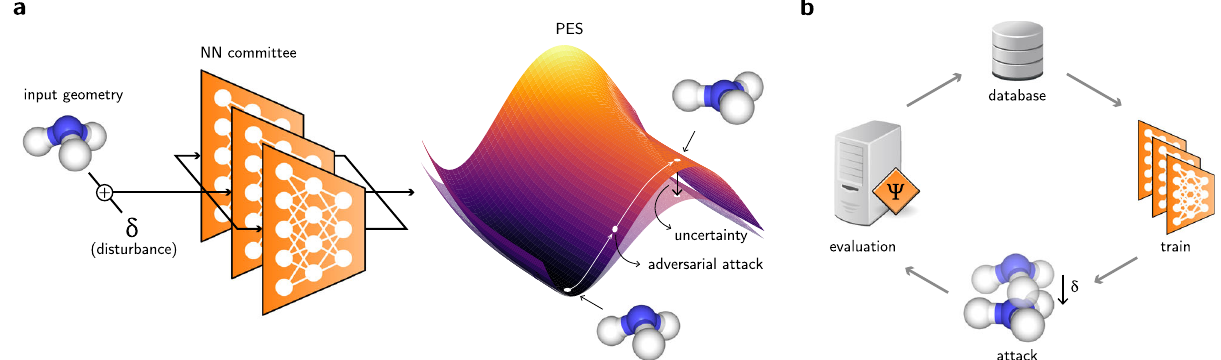
Fig. 1 Schematic diagram of the method. a Nuclear coordinates of an input molecule are slightly displaced by δ . Then, a potential energy surface (PES) and its associated uncertainty are calculated with an NN potential committee. By backpropagating an adversarial loss through the NN committee, the displacement δ can be updated using gradient ascent techniques until the adversarial loss is maximized, thus converging to states that compromise high uncertainty with low energy. b Schematic diagram of the active learning loop used to train the NN potential committee. The evaluation can be